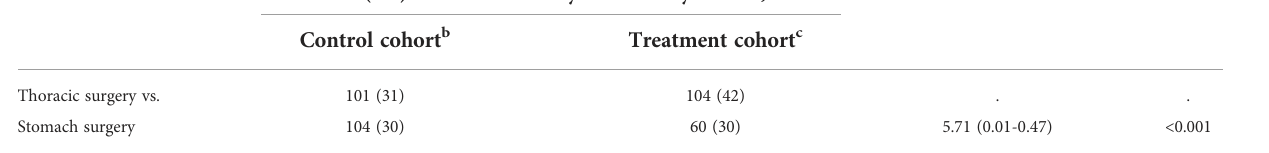
TABLE 2 Pair-wise Comparison in Relative Weekly Volumes of two Surgery Types. Mean (SD) of relative weekly volumes by month, % a